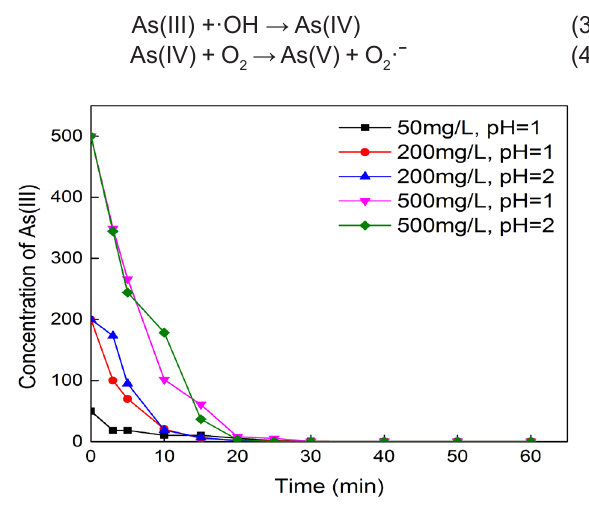
Fig. 4. Effect of pH on As(III) oxidation with ozone at 20°C Effect of temperature and Fe 3+ : In our work, the experiment was carried out for testing the effect of temperature on oxidation of As(III) with ozone in an acidic solution at its low (50 mg/l) and high initial (5 g/l) concentrations. Experiment results show that at 25°C the ozone oxidation was efficient but at 90 °C there was no difference in the concentration of As(III) in the solutions between initial and after reactions at pH 1 and 2 as shown in Table 1 in absence of Fe 3+ . Whereas, in presence of Fe 3+ , 5 g/l As(III) was oxidized 97.2% and 90.6% at pH 2 and 1, respectively, in 2 hours as shown in table 1, which depicts the comparison of the presence and absence of Fe 3+ on the oxidation of